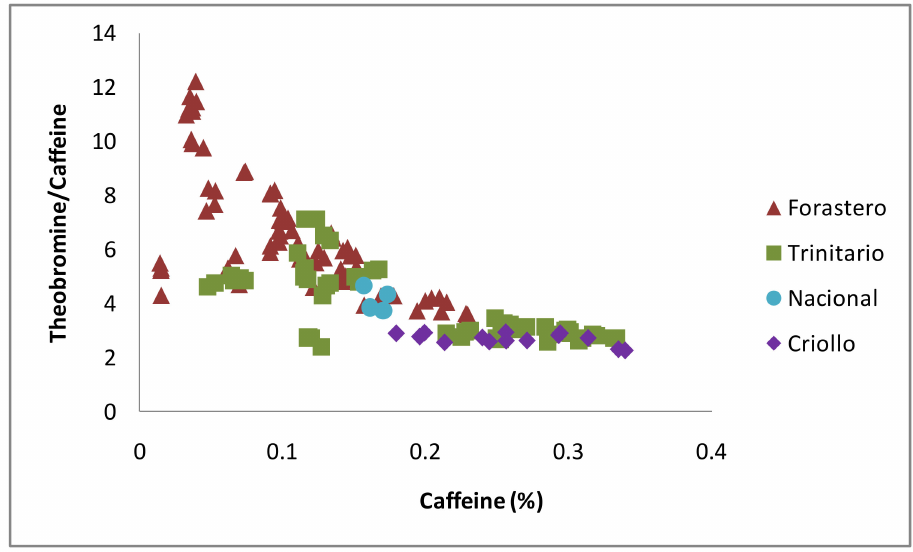
Figure 5. Relationship between methylxanthine content in CBS and CBS